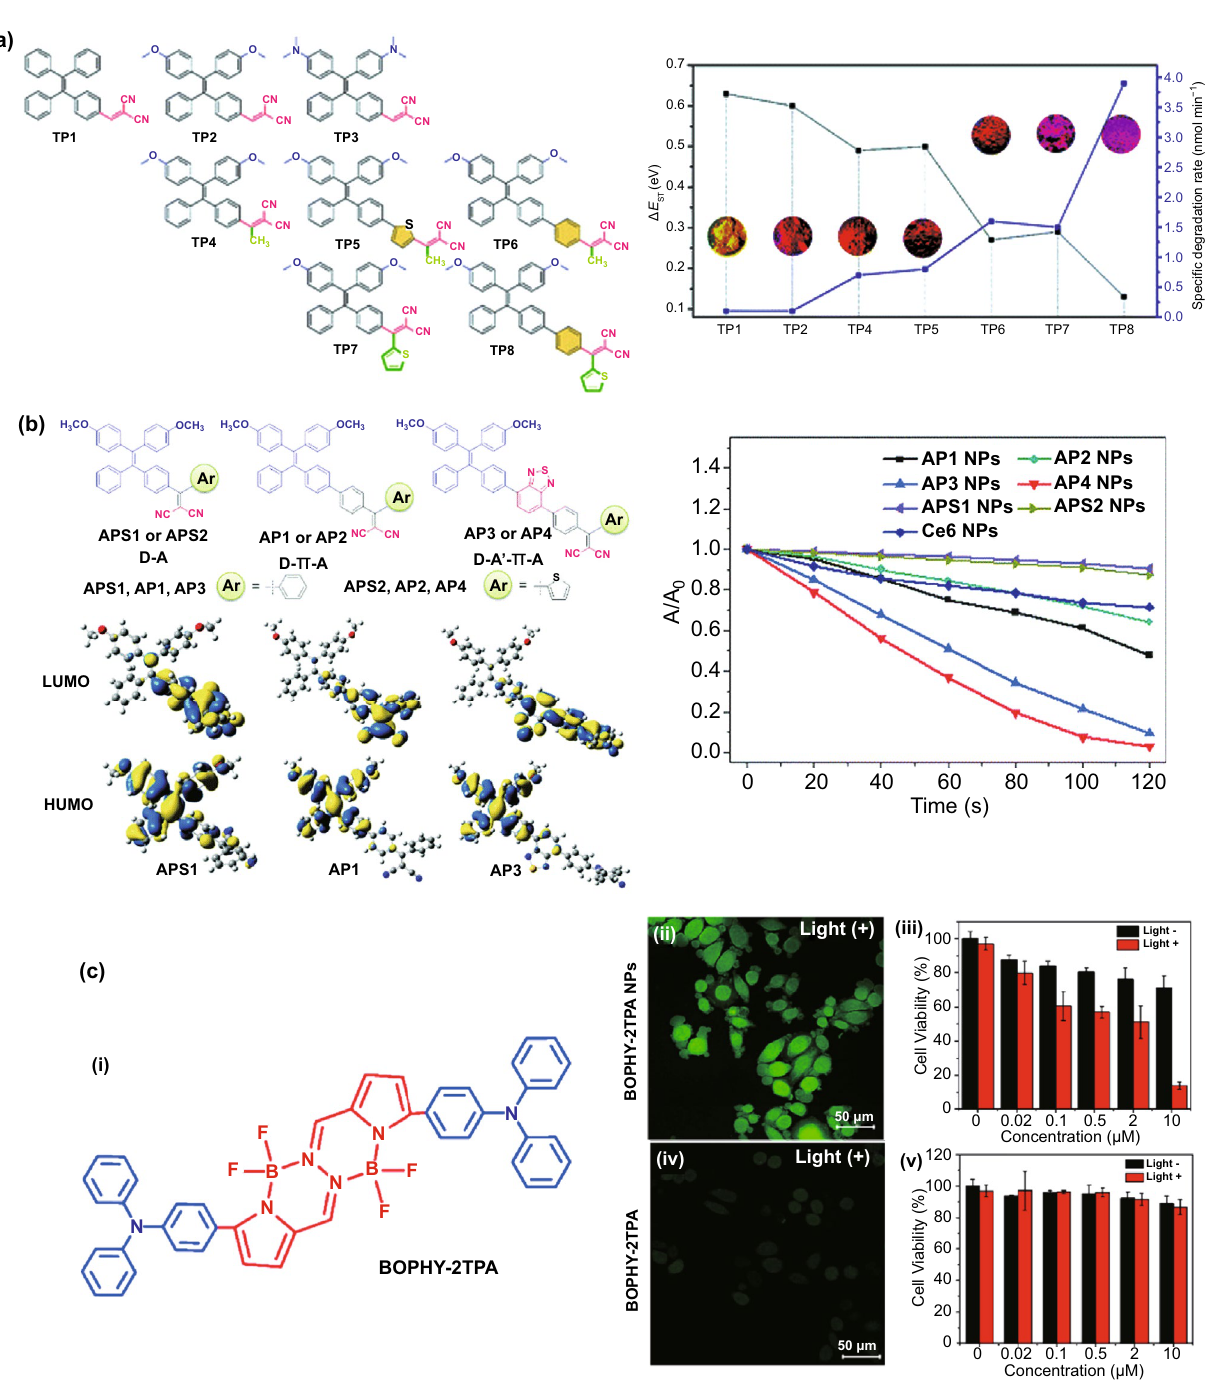
Fig. 5 a Left: Chemical structure of different Type II AIE photosensitizers, Right: The Δ E ST values (black curve), specific degradation rates (degradation rate per absorption area of the PS, 400–700 nm) and solid power images under 365 UV light illumination (inset), reproduced from Ref. [95] with permission from Royal Society of Chemistry. b Left: Chemical structures and HOMO–LUMO distributions, and Right: relative degradation of 9,10-anthracenediyl-bis(methylene) dimalonic acid (ABDA) in the presence of different photosensitizers, reproduced from Ref. [97] with permission from Royal Society of Chemistry. c (i) Chemical structure of BOPHY-2TPA AIE photosensitizer molecule, (ii) fluores- cence image of intracellular ROS generation in HeLa cells detected by DCFH-DA as singlet oxygen probe, and HeLa cell viability by (ii, and iii) BOPHY-2TPA nanoparticles and (iv, v) BOPHY-2TPA molecule, reproduced from Ref [99]. with permission of American Chemical Society. (Colour figure